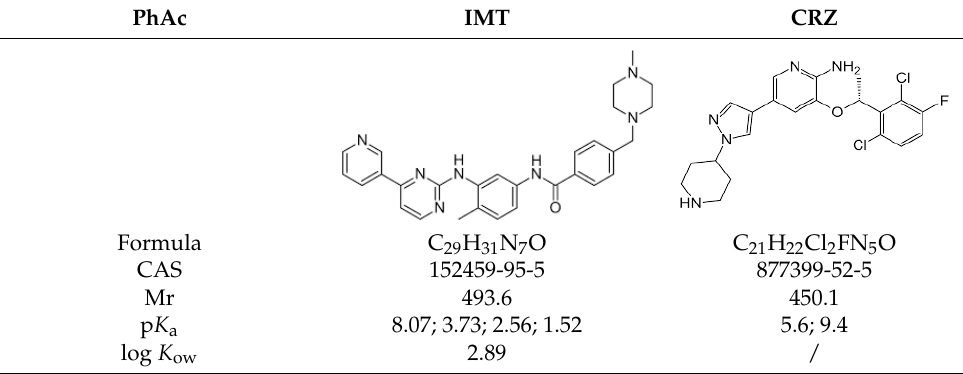
Table 1. Physicochemical properties of pharmaceuticals [14,26,27].